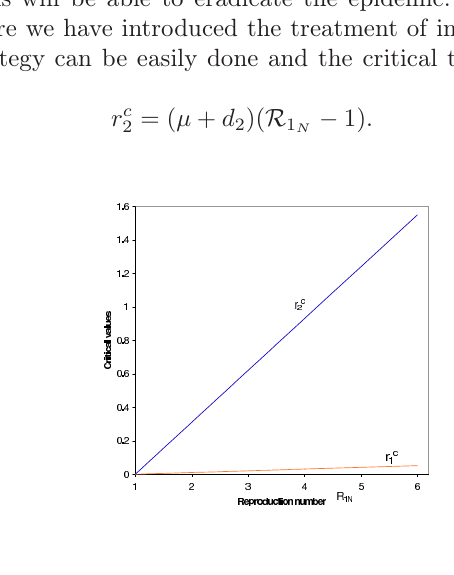
Figure 2. Graphs of the critical chemoprophylaxis ( r c 1 ) and treatment ( r c 2 ) values against R 1 N for µ = 0 . 01 , d 1 = 0 . 3 , k 1 = 0 . 0002